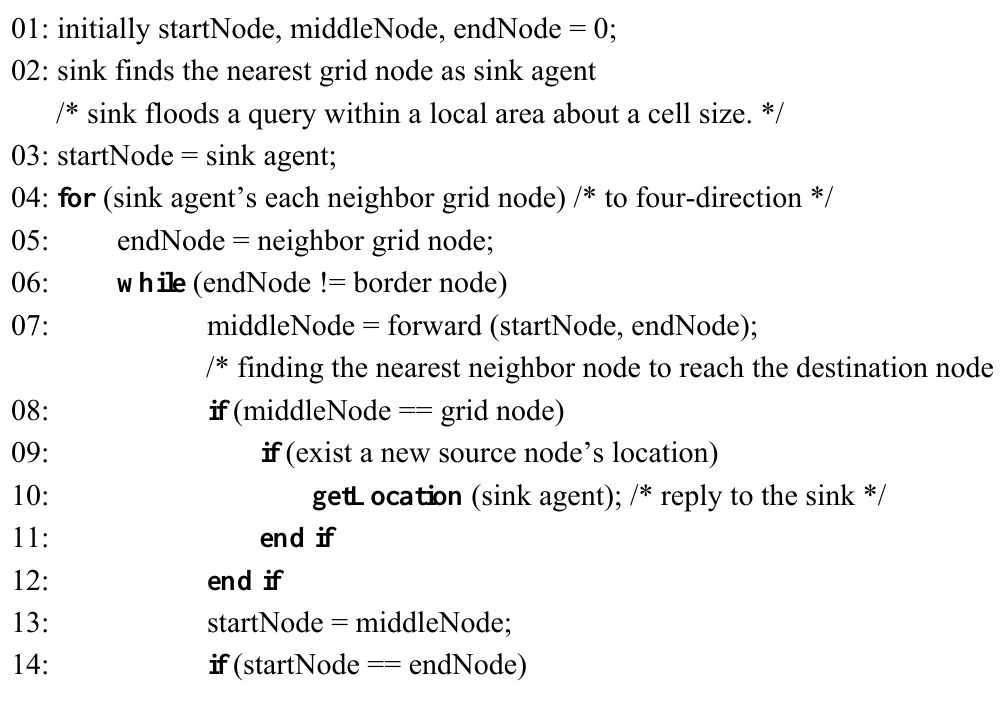
Algorithm 2. Pseudo-code to find location of source nodes at